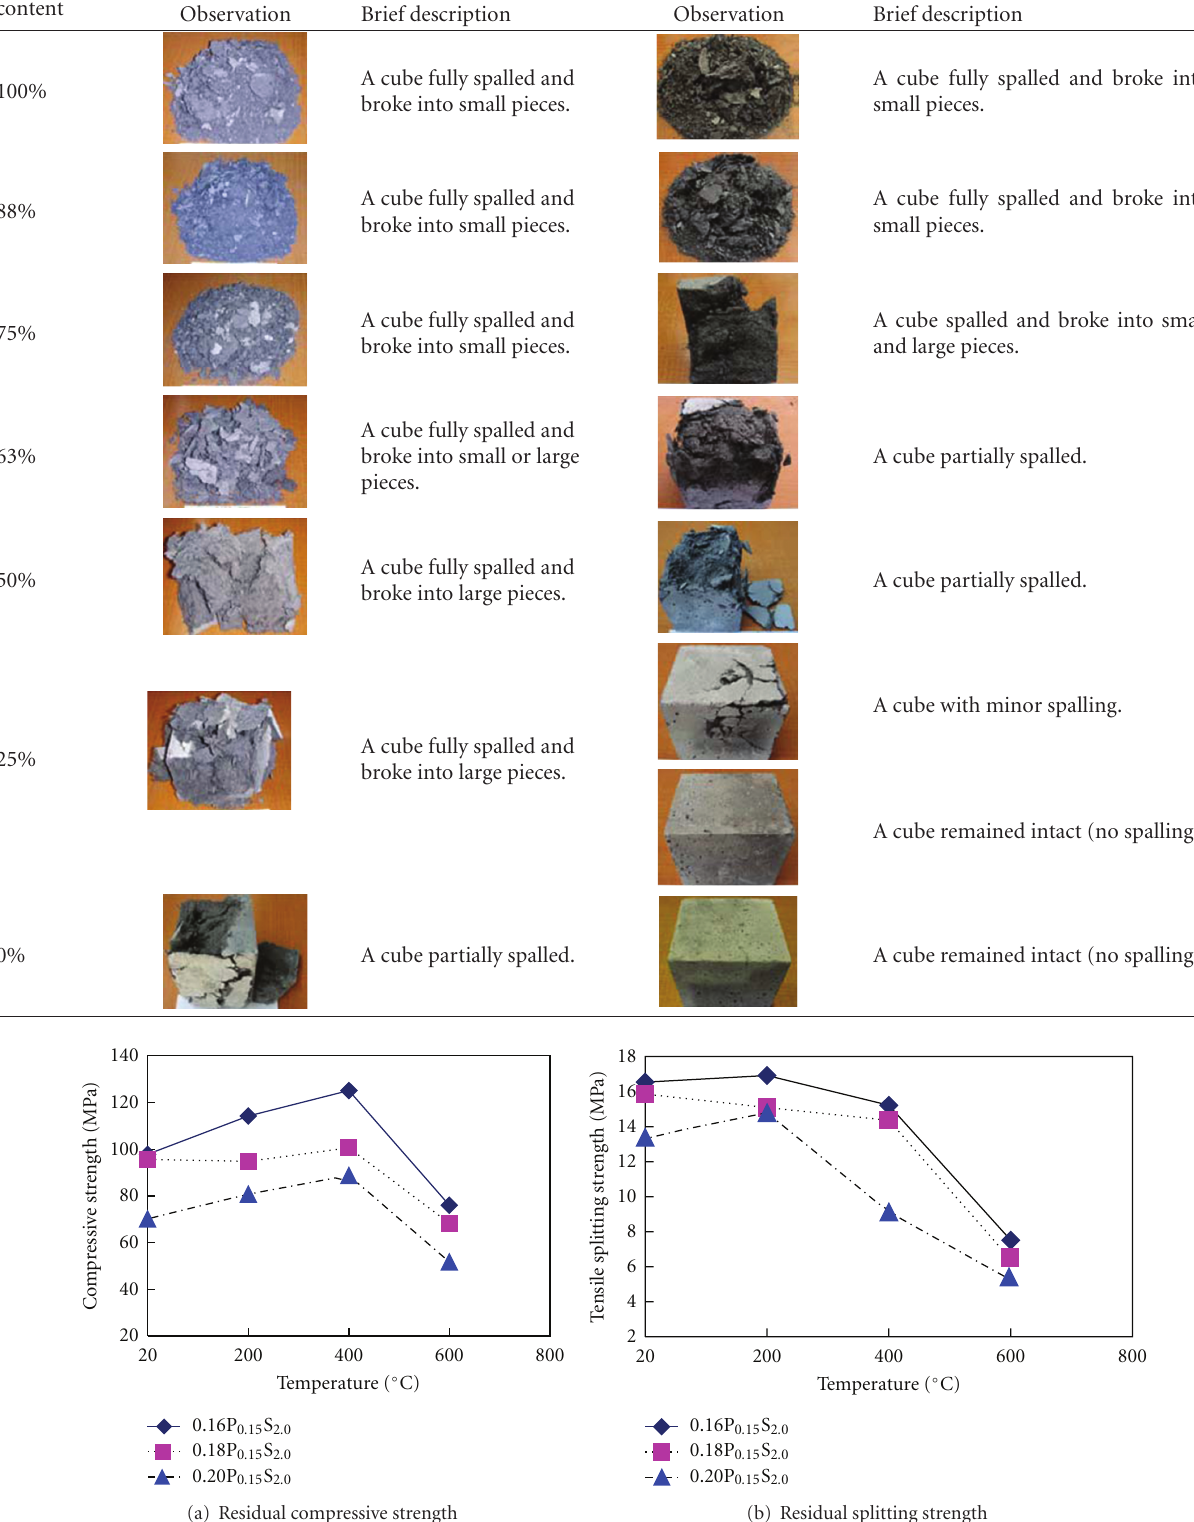
Figure 3: Residual strength of RPC with di ff erent W/B